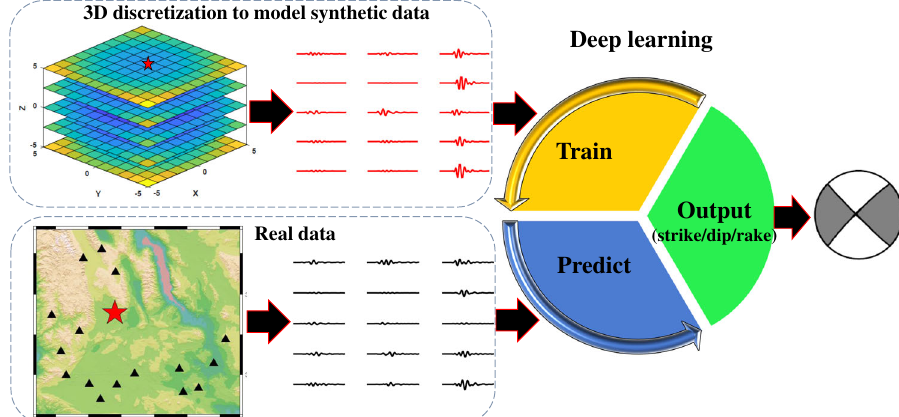
Fig. 2 Schematic fl owchart illustrating the framework of determining source focal mechanism via deep learning. First, we discretize the monitoring area of interest into three-dimensional (3D) grids and simulate the theoretical waveforms (red waveforms) as training data to train a designed FMNet. Then, when a real earthquake occurs (red star), we directly feed the recorded waveforms (black waveforms) into the well-trained FMNet and output the earthquake focal mechanism directly.